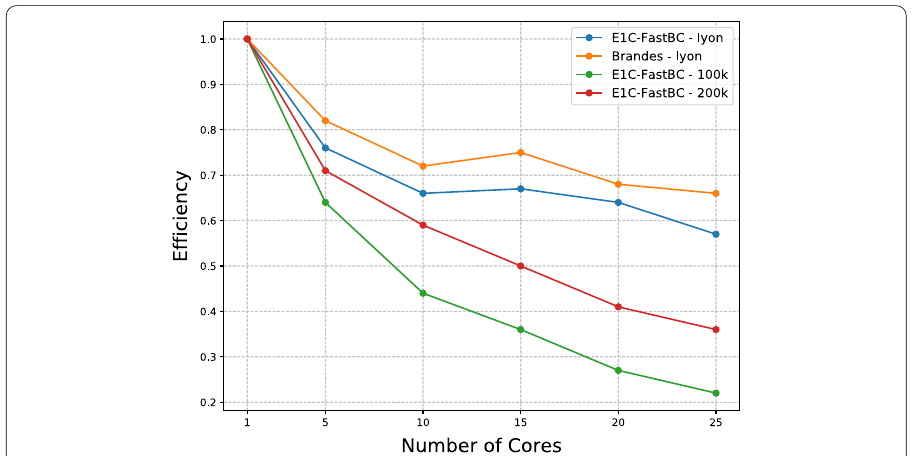
Fig. 12 Efficiency analysis for lyon-road-network graph- E p =[ 1,5,10,15,20,25 ] . Comparison with synthetic graphs having similar size (100k and 200k nodes) and with Brandes’ algorithm on the same